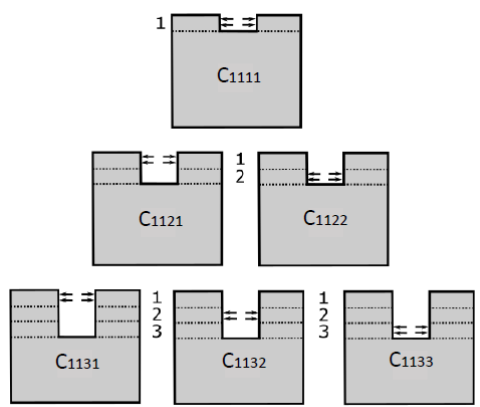
Figure 2. Schematic detailing the stress state and hole depth considered to obtain the calibration coefficients for the initial three drilling